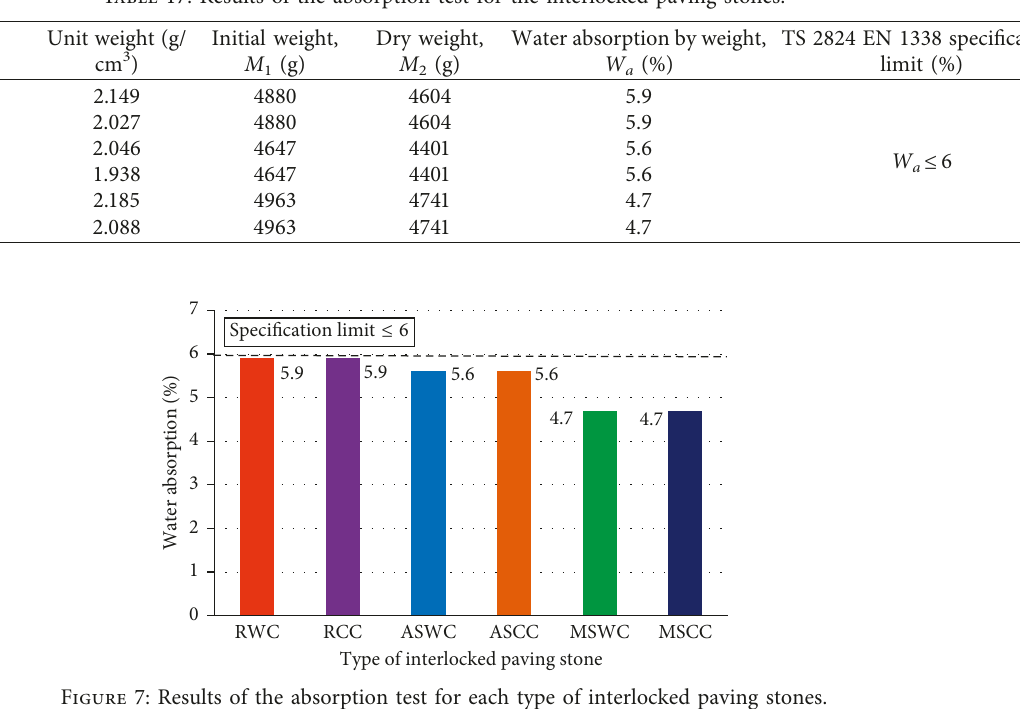
Figure 6: The appearance of the drying oven curing and interlocked paving stones. (a) The drying oven curing. (b) RWC and RCC paving stones. (c) RWC and RCC paving stones. (d) MSWC and MSCC paving stones. Table 17: Results of the absorption test for the interlocked paving stones.